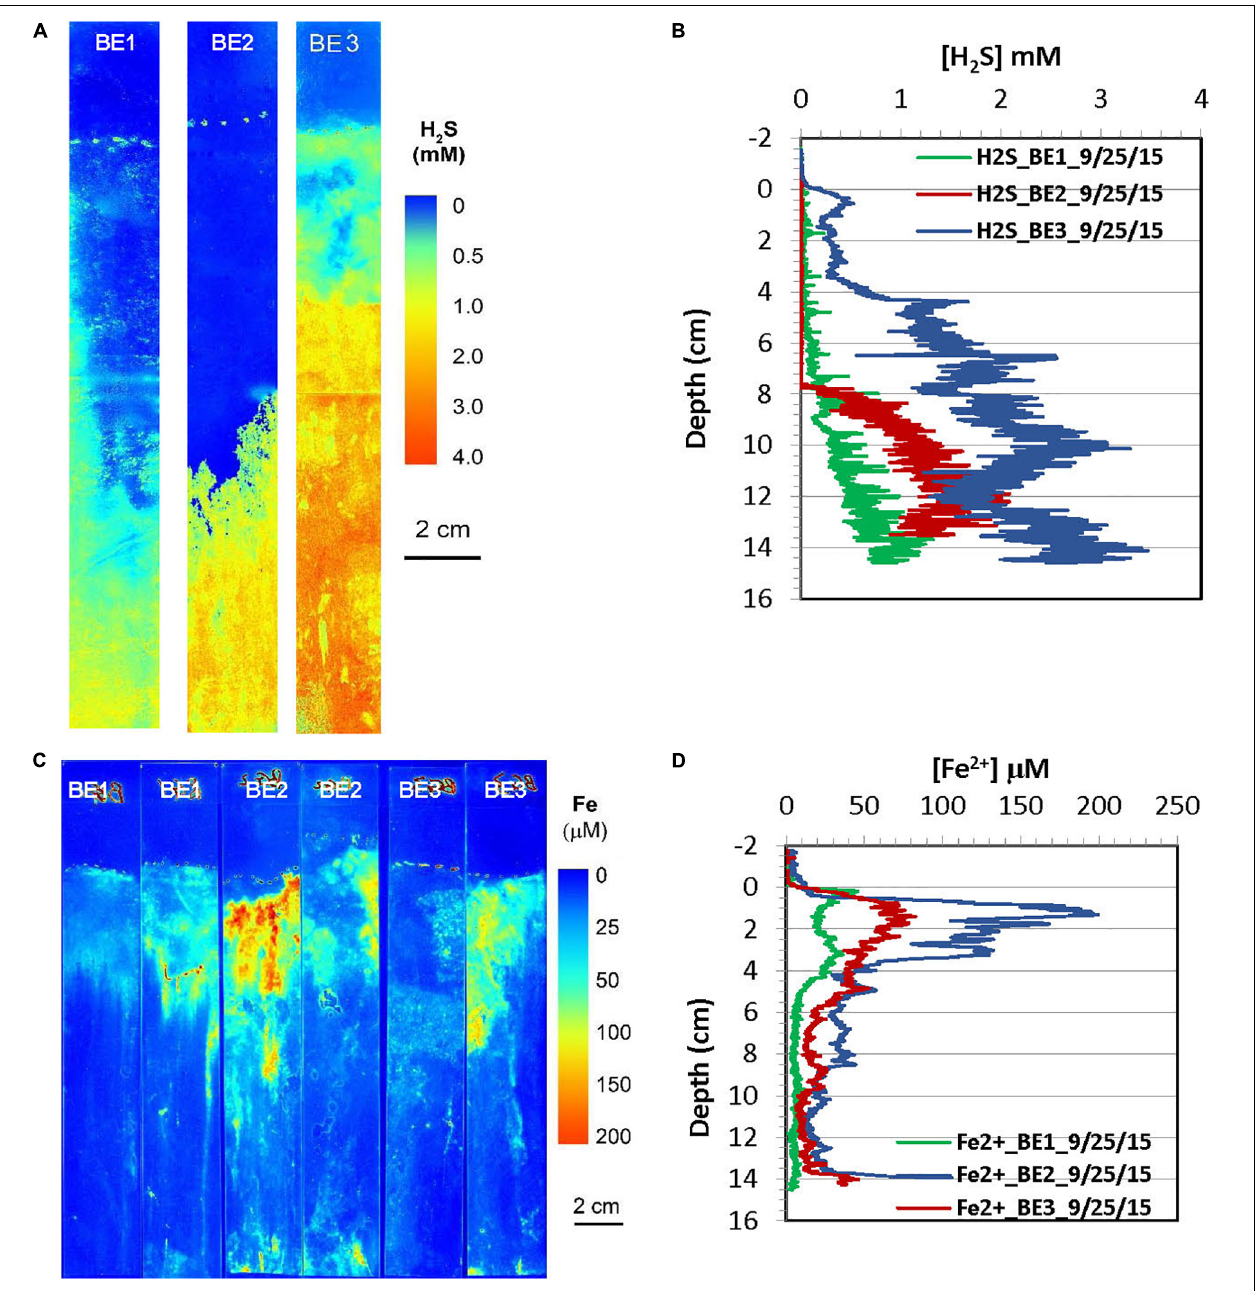
FIGURE 8 | H 2 S and dissolved Fe 2 + distribution patterns in the pore water of Big Egg (BE) marsh peats in summer 2015. (A) 2-D H 2 S distribution patterns (pseudo color) obtained by in situ measurements in sediments; white line marks the peat surface. (B) Vertical H 2 S profiles averaged from each 2-D H 2 S distribution in the panel (A) . (C) 2-D Fe 2 + distribution patterns obtained by in situ deployments; white line marks the peat surface. (D) Vertical Fe 2 + profiles averaged from each 2-D Fe 2 + distributions in the panel (C)